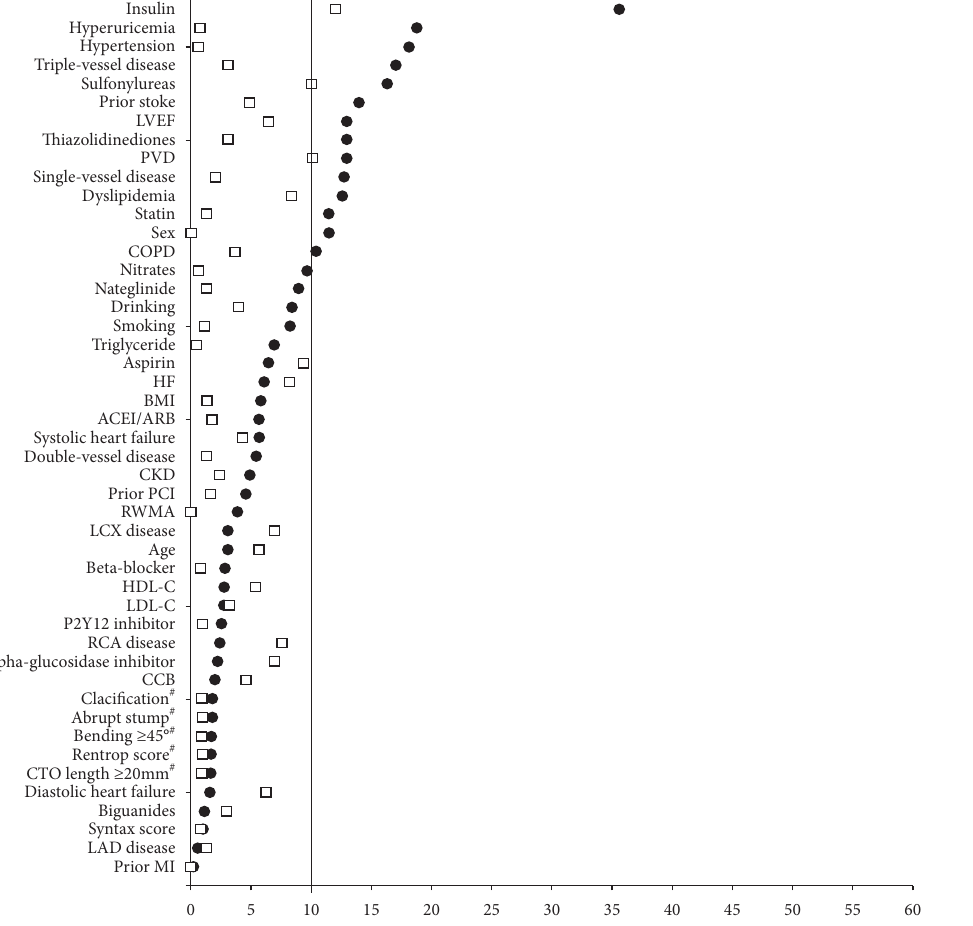
Figure 3: Standardized differences before and after propensity score match. Absolute standardized difference less than 10% indicates match well. CKD: chronic kidney disease; COPD: chronic obstructive pulmonary disease; PVD: peripheral vascular disease; MI: myocardial infarction; PCI: percutaneous transluminal coronary intervention; HF: heart failure; BMI: body mass index; ACEI/ARB: angiotensin- converting enzyme inhibitor/angiotensin-receptor blocker; CCB: calcium-channel blocker; HDL-C: high-density lipoprotein cholesterol; LDL-C: low-density lipoprotein cholesterol; LAD: left anterior descending; LCX: left circumflex; RCA: right coronary artery; LVEF: left ventricular ejection fraction; RWMA: regional wall motion abnormality. #Cine angiogram records got from 906 (88.05%) individuals. Table 3: Estimated Kaplan–Meier events rates in propensity score-matched population. HbA1c <